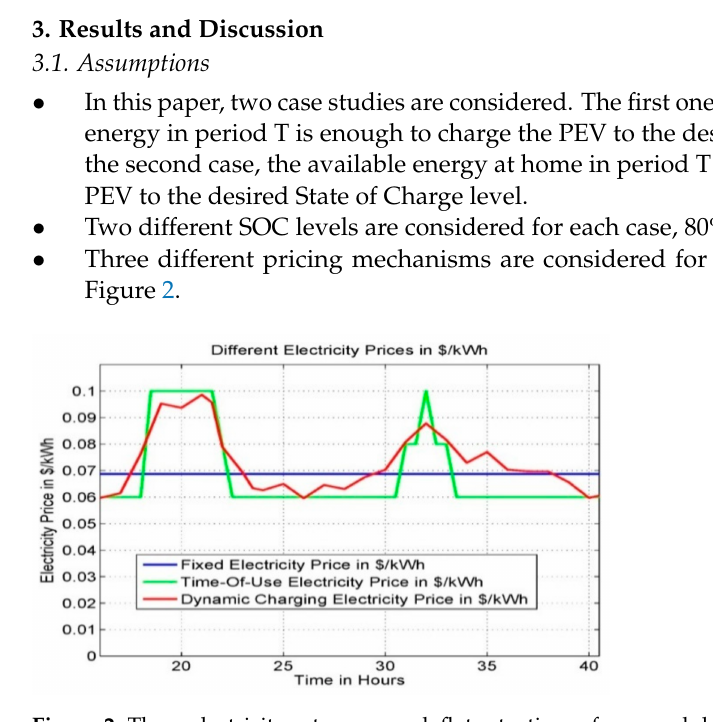
Figure 2. Three electricity rates are used, flat rate, time-of-use, and dynamic